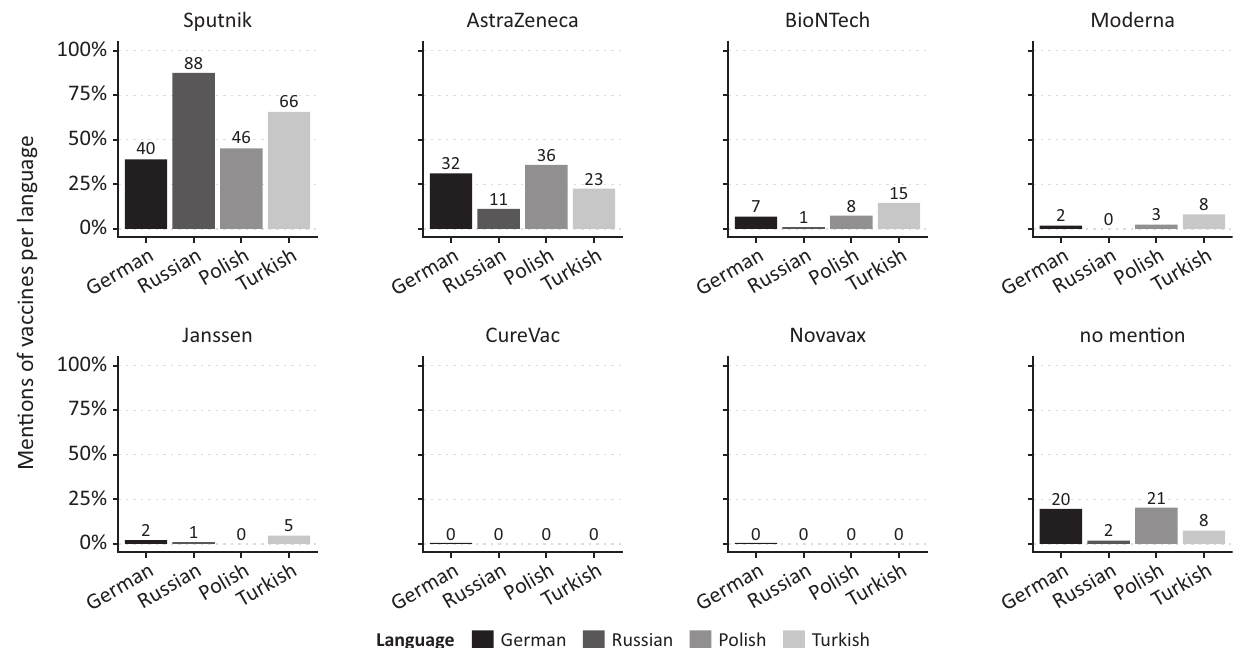
Figure 4. Mentions of specific vaccines in different languages. Notes: The base for each language are all manually coded tweets about Covid‐19 vaccination; n = 3,205, German ( n = 2,658), Russian ( n = 420), Polish ( n = 39), and Turkish ( n = 88); Cramer’s V = 0.19; p < 0.01.